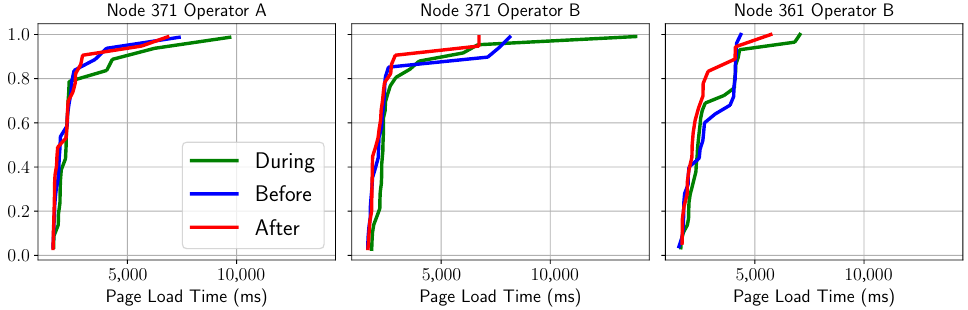
Figure 7. CDF of HTTP page load time (Wikipedia main page) before/during/after the match. To conclude this section, the results obtained for the KQI of the ping service (i.e., RTT) corroborate the hypothesis that there is different behavior in each of the phases of the game, degrading especially during and before it, and improving afterwards. Figure 8 shows the CDF for each of the phases, and unlike the previous cases, the behaviors of both operators were fairly similar.